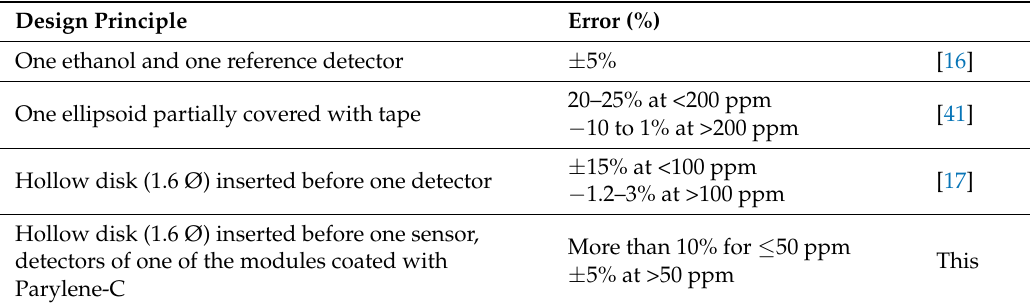
Table 3. Comparison of design principle and performances among this sensor and previously reported ethanol sensors